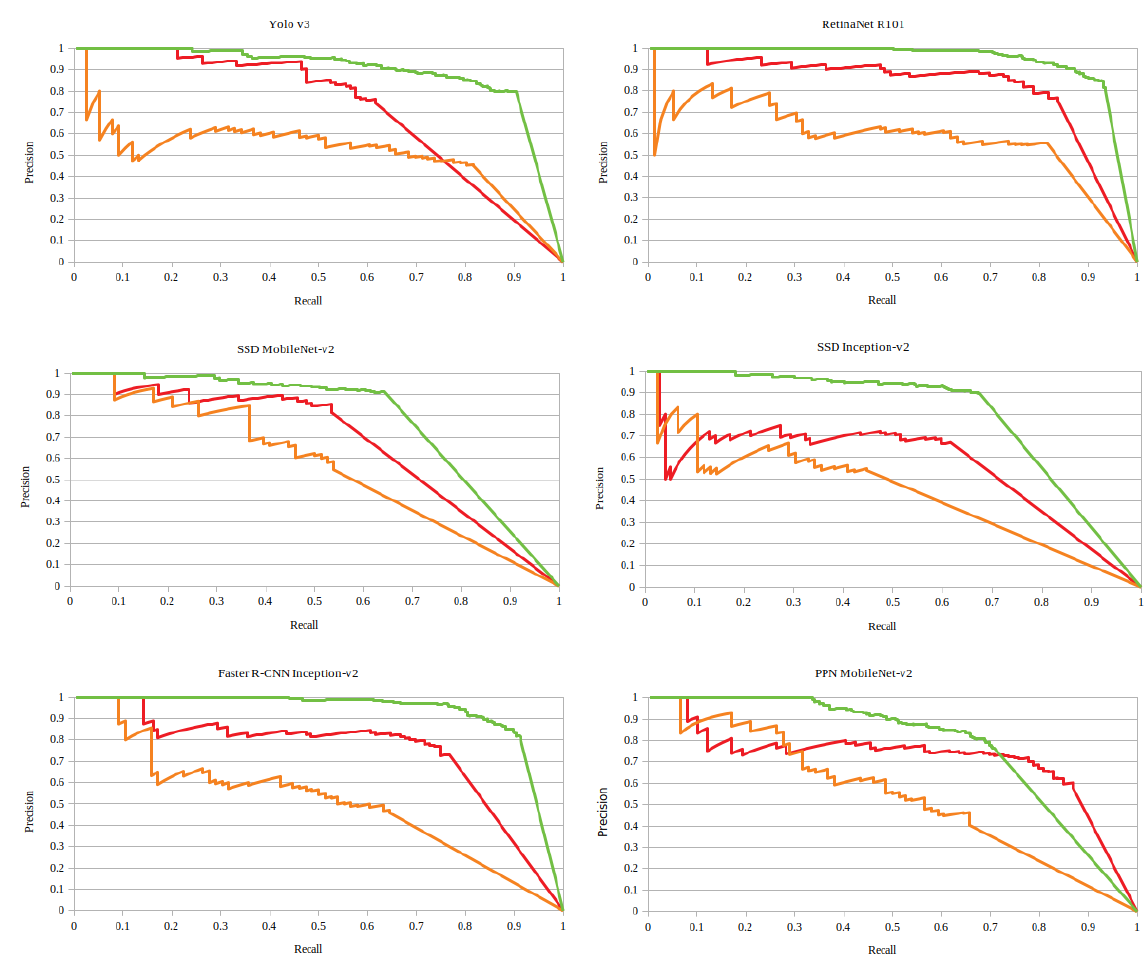
Figure 8. Precision-Recall curves for each OD algorithm and class: fully ripe (red), semi-ripe (orange), unripe (green)